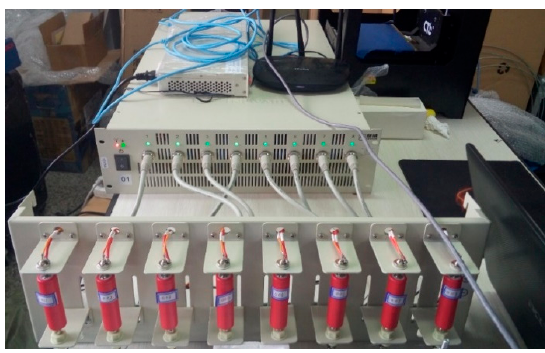
Figure 1. Battery Test System 4000 (BTS4000) power battery testing bench.